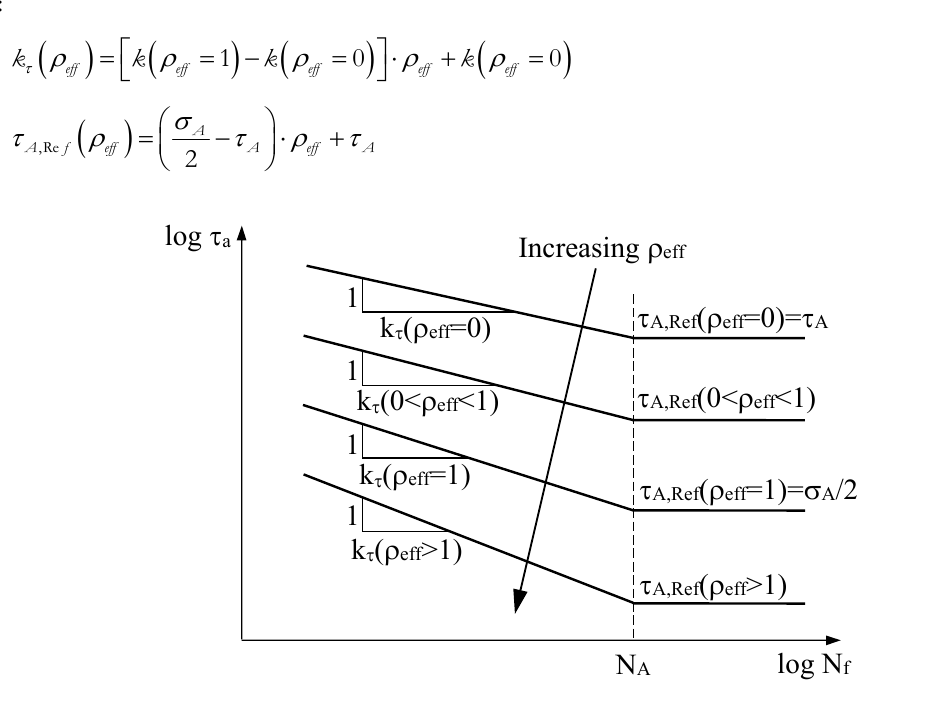
Figure 5: Modified Wöhler